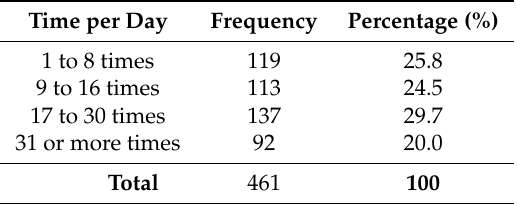
Table 5. Frequency of checking smartphone or cell phone per day.